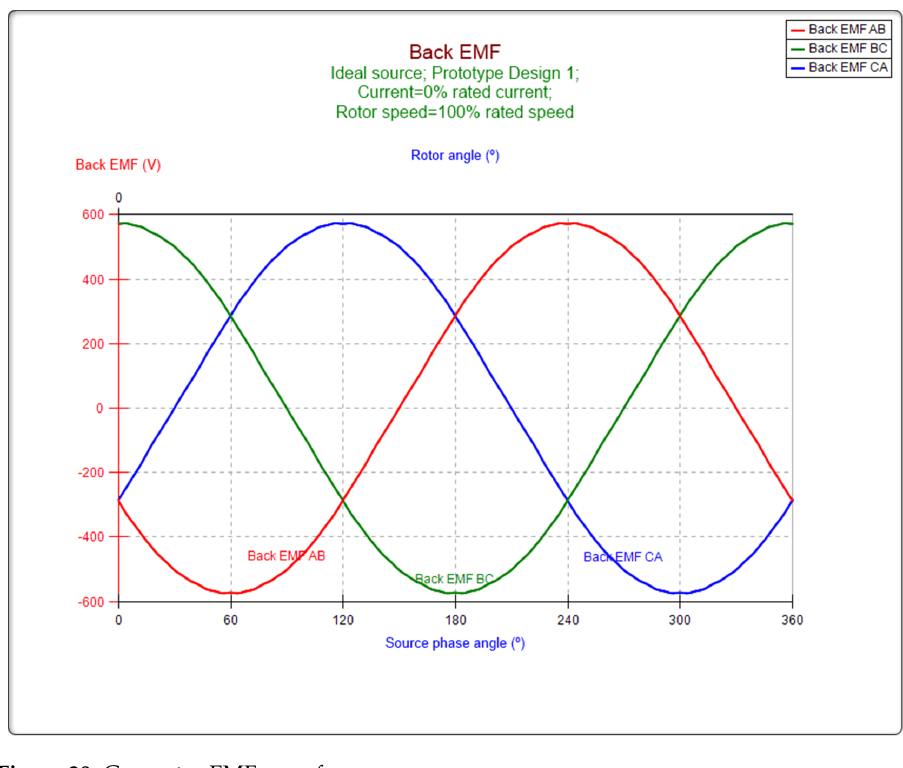
Figure 20. Generator EMF waveforms.